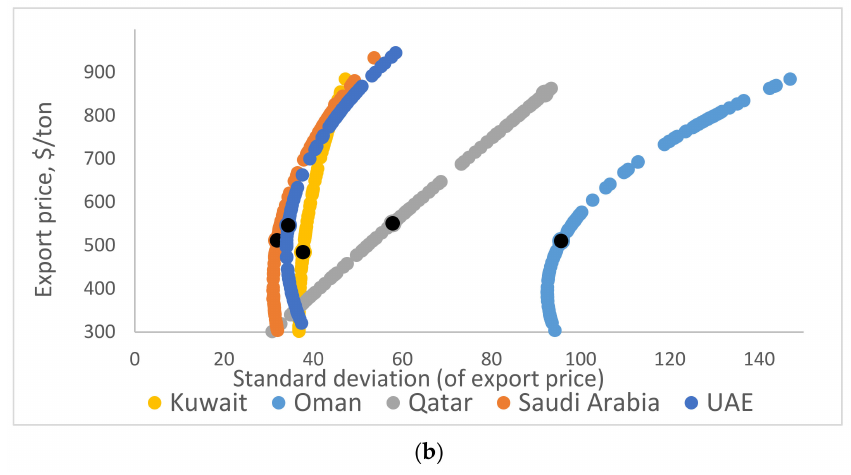
Figure 2. ( a ): Efficient oil export frontiers: export growth rate. ( b ): Efficient oil export frontiers: export price. Note: Black dots represent average monthly values observed in